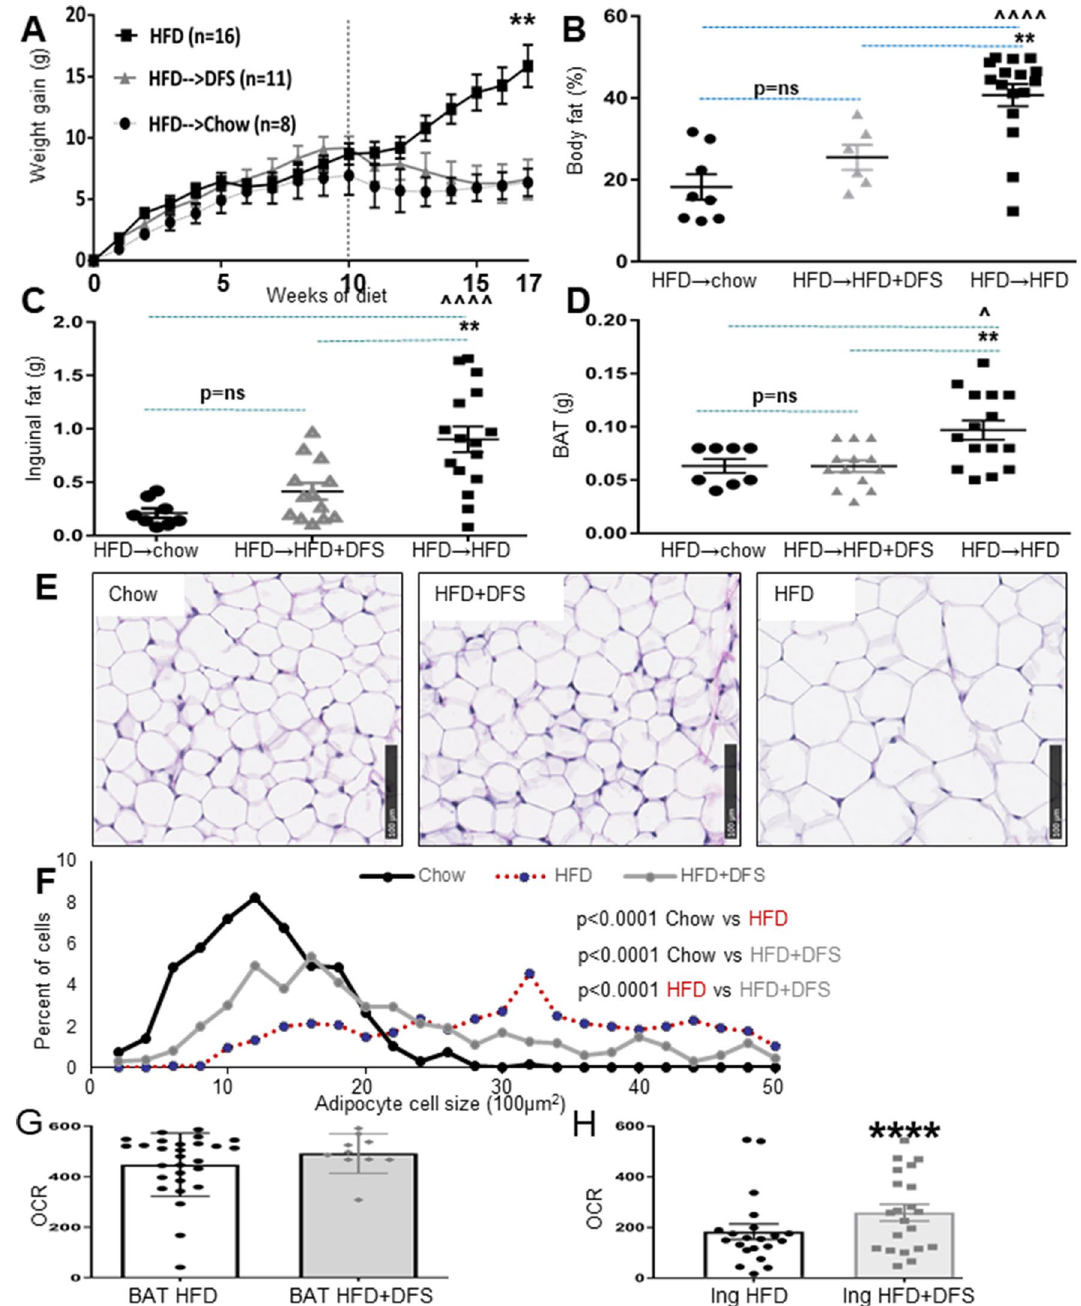
Figure 4. Deferasirox causes weight loss after high-fat diet (HFD) induced weight gain. ( A ) All mice were fed HFD for 10 weeks, then mice were continued on HFD, switched to HFD + DFS or switched to chow. Figure shows weight gain from start of HFD. ( B ) Mice which continued HFD had greater percentage body fat (assessed by DEXA), and ( C ) greater weight of inguinal fat and ( D ) brown adipose tissue (BAT). ( E ) Representative images of fat from chow, HFD + DFS and HFD mice. ( F ) Quantification of fat cell size in mice switched to chow, HFD or HFD + DFS. ( G ) Oxygen consumption rate (OCR) of BAT explants, measured using Seahorse bioanalyzer. ( H ) Oxygen consumption rate of explants of inguinal fat from HFD and HFD + DFS mice. Dots indicate individual values for each mouse. *p < 0.05, **p < 0.01, ***p < 0.001, ****p < 0.0001 DFS + HFD versus HFD mice. ^p < 0.05, ^^p < 0.01, ^^^^p < 0.0001 in HFD versus chow mice. Data is shown as mean ± SEM (standard error of the mean) unless otherwise